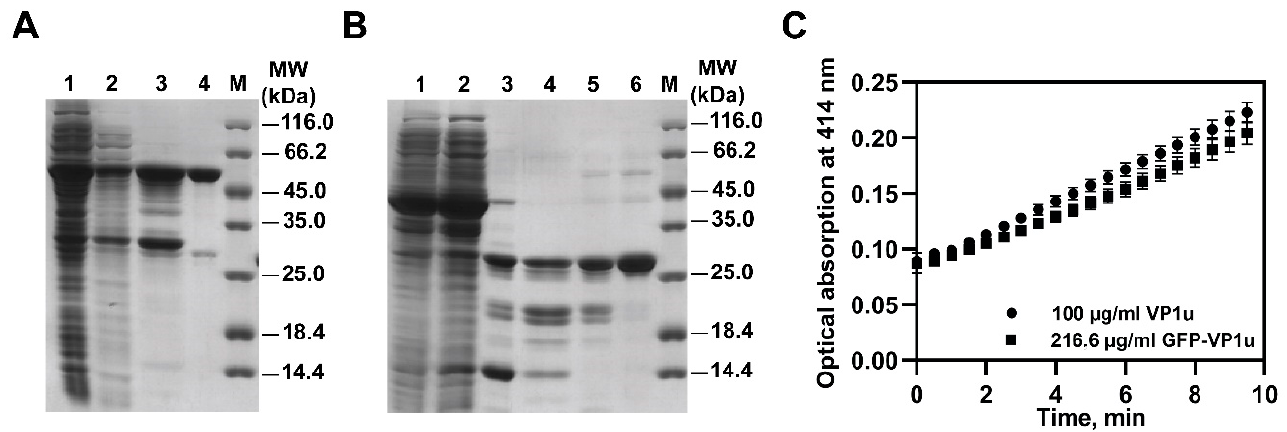
Figure 2. Recombinant VP1us purification and the assessment of the phospholipase A2 (PLA2) enzymatic activity. ( A ) SDS-PAGE gel displaying the GFP-VP1u purification stages: 1—crude extract, 2—cell-free supernatant, 3—proteins eluted from Ni-NTA-agarose column, 4—purified proteins after Phenyl FF column, M—molecular marker. ( B ) SDS-PAGE gel displaying the VP1u purification stages: 1—crude extract, 2—cell-free supernatant, 3—proteins eluted from Ni-NTA-agarose column, 4—separation of VP1u from Trx using a Ni-NTA-agarose resin column, 5—purified proteins after Phenyl FF column, 6—purified and concentrated protein after the additional Phenyl FF column, M—molecular marker. ( C ) PLA2 enzymatic activity results of VP1u and GFP-VP1u recombinant proteins. The results are shown as mean ± SD.